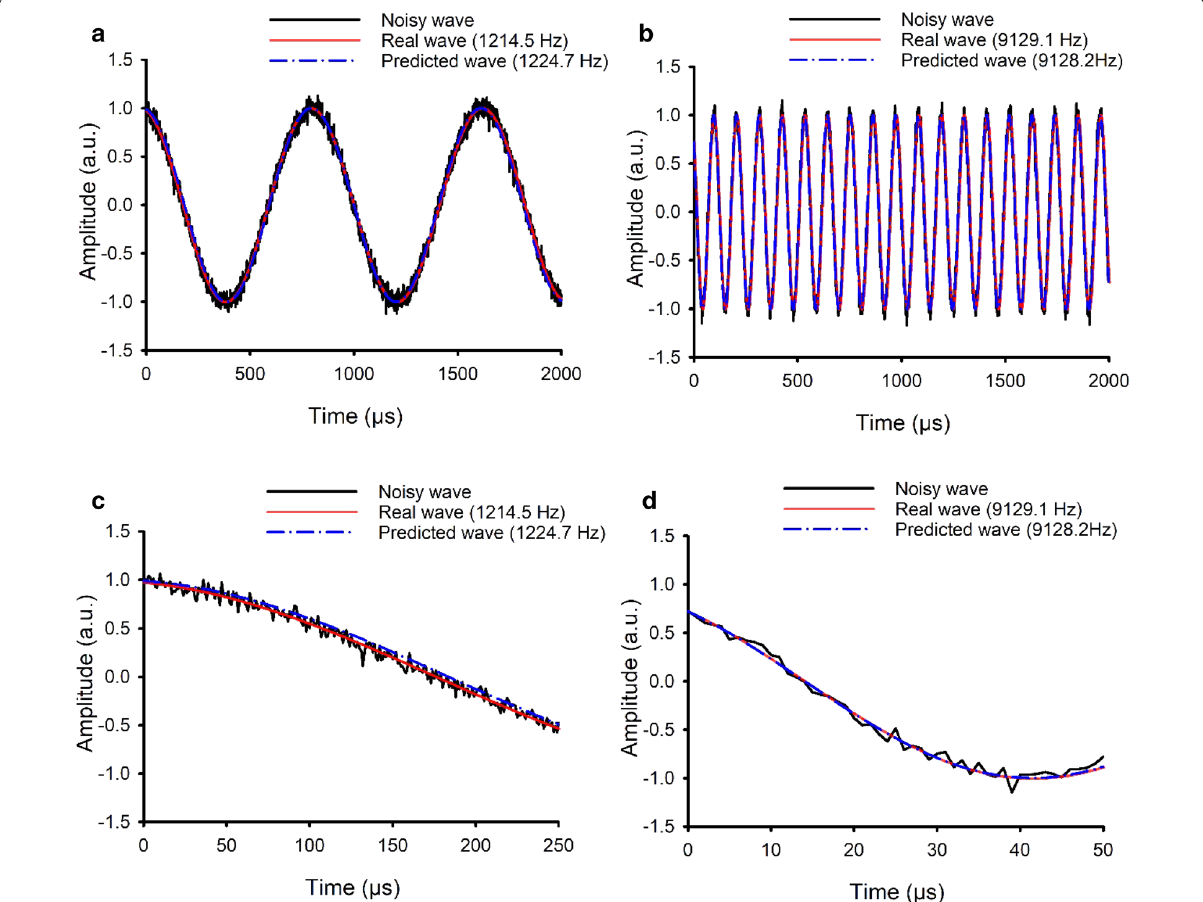
Fig. 3 Accuracy of the NN model: examples a 1214.5 Hz and b 9128.2 Hz, and zoomed views for c 1214.5 Hz and d 9129.1 Hz